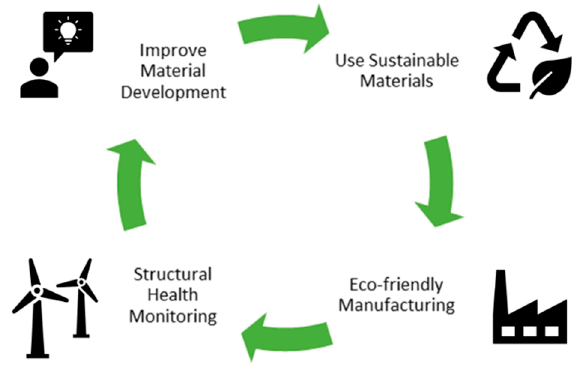
Figure 1. Cycle for sustainable material development enabled by low-cost resource-efficient sensors for structural health monitoring.